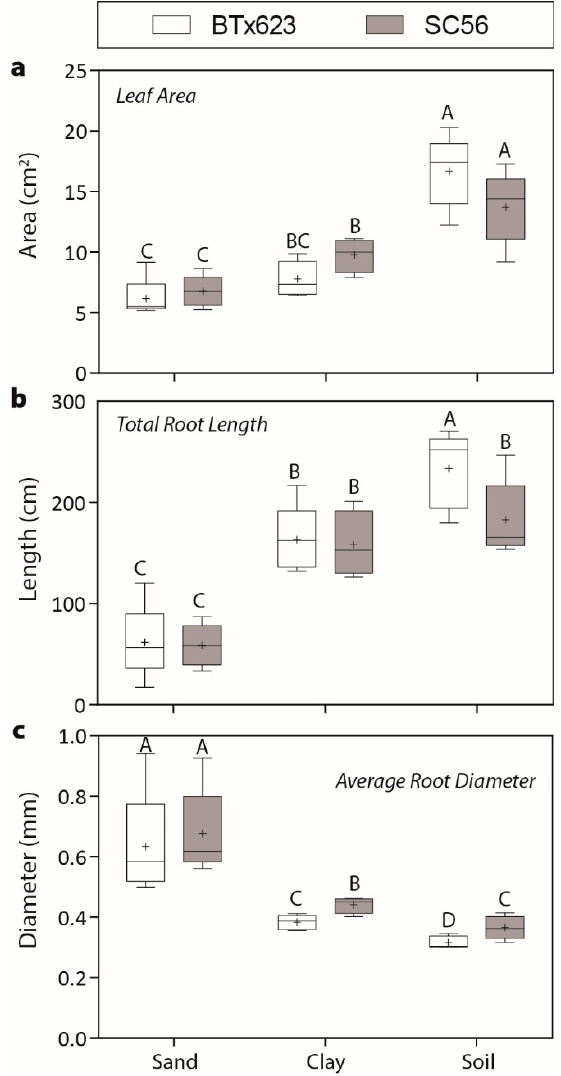
Figure 2. Morphological trait variation. Boxplots for ( a) leaf area, ( b) total root length, and ( c) average root diameter. Boxplots represent median (line inside each box) and the bottom and top of boxes represent the lower and upper quartiles, respectively. The mean is indicated with a (+) and the bottom and top of each whisker represent the minimum and maximum of each observed trait, respectively. Uppercase letters indicate statistical significance (Student’s t ) between means assessed within each trait measured.